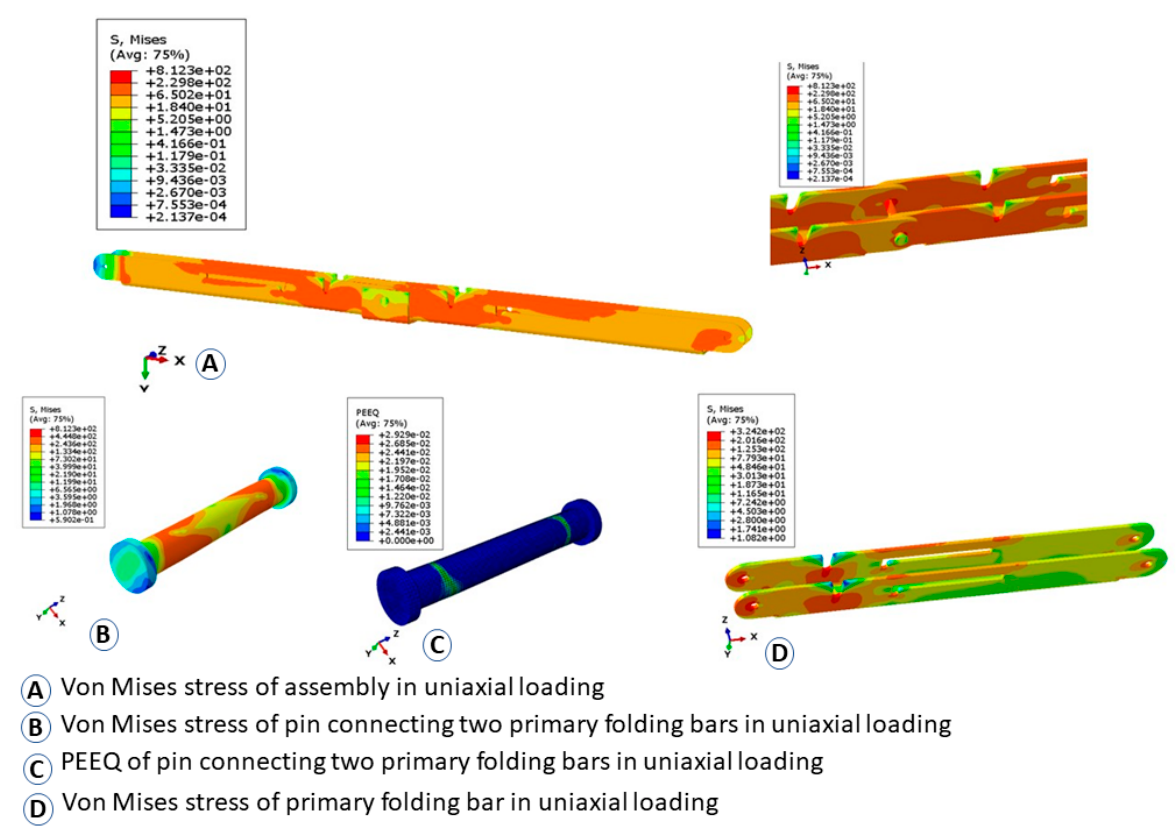
Figure 39. Von Mises stress (MPa) and PEEQ plot of uniaxial loading of primary folding link bar and pin (P = 15,000N).